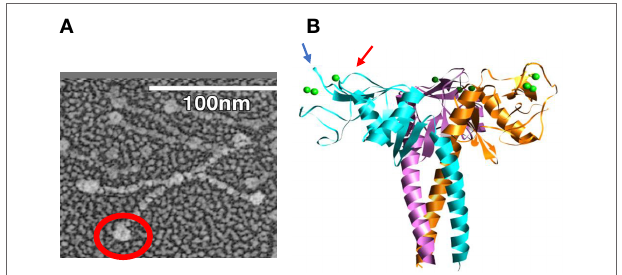
FiGURe 1 | Electron micrograph of dodecameric, intact surfactant protein D (SP-D) molecule (A) , electron micrograph of full length dodecameric SP-D (B) and structure of H3N2 influenza A viruses hemagglutinin with glycan attachments. The red circle in panel (A) is included to highlight the globular NCRD component of the molecule. In panel (B) , the blue and red arrows indicate ridges surrounding the lectin binding site of the NCRD. The ridge indicated by the blue arrow is formed by the D325 residue and that shown by the red arrow is formed by R343 [this figure was adapted from Ref. (14)].